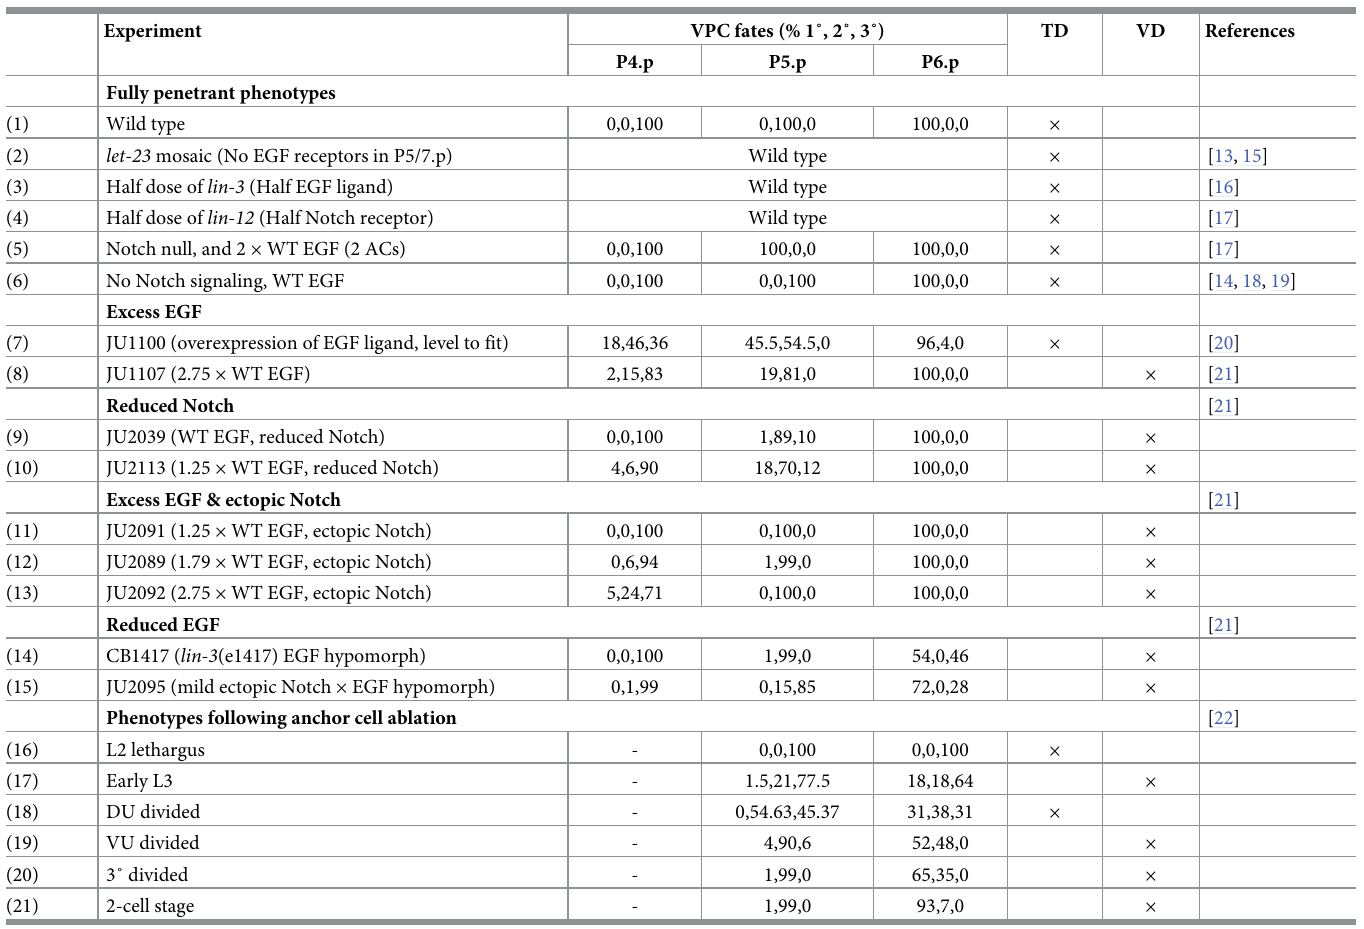
Table 1. Table of experimental data obtained from the literature [5].